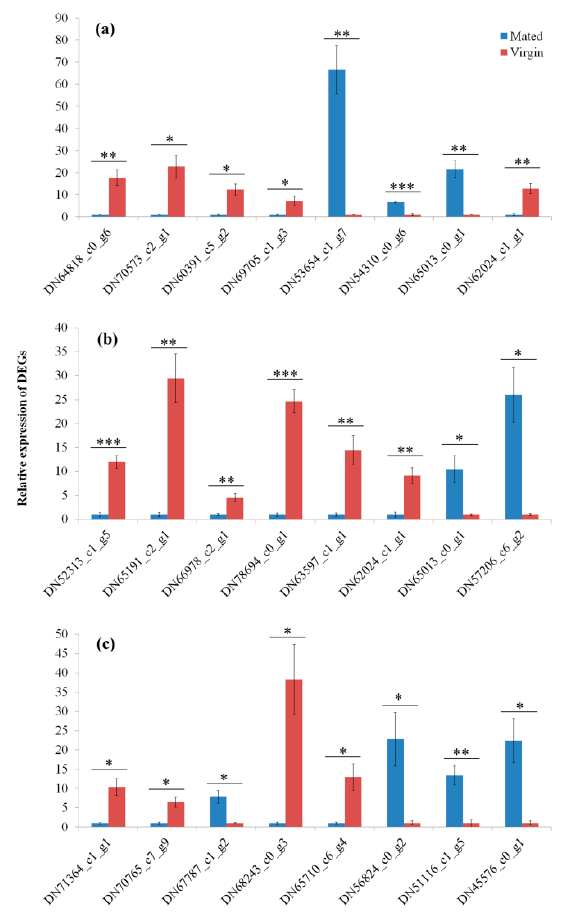
Figure 7. The validation of RNAseq results by quantitative real-time PCR. ( a ) DEGs from Mated-1 h vs. Virgin-1 h, ( b ) DEGs from Mated-6 h vs. Virgin-6 h, and ( c ) DEGs from Mated-24 h vs. Virgin-24 h. * indicates p < 0.05; ** indicates p < 0.01, *** indicates p < 0.001. Error bars indicate SE.